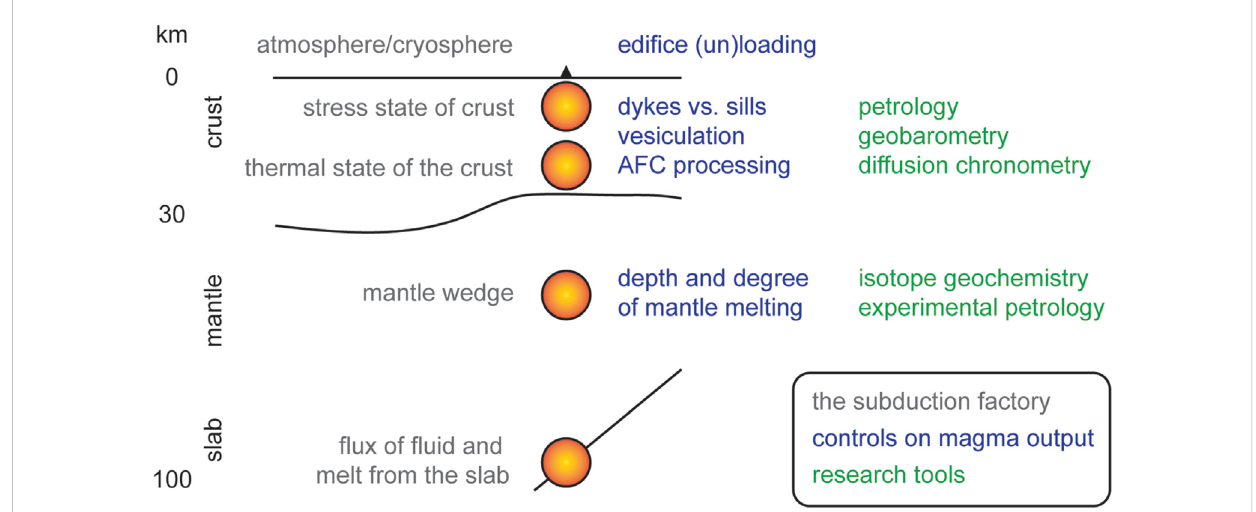
FIGURE 8 A summary of the components and characteristics of glaciated arc systems (grey text) that are in fl uenced by processes controlling magma output (bluetext),andsomekeyresearchtoolsthatcanbeusedtodeterminehowsuchprocessesoperate(greentext).Thegraphicpresentsacross-sectionofa typical arc with depths and lithologies labelled in black